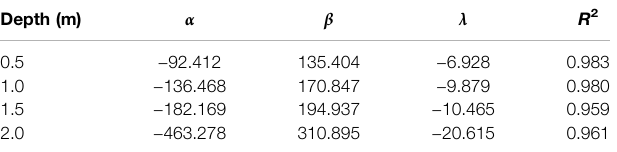
TABLE 3 | Parameters of matrix suction prediction model.